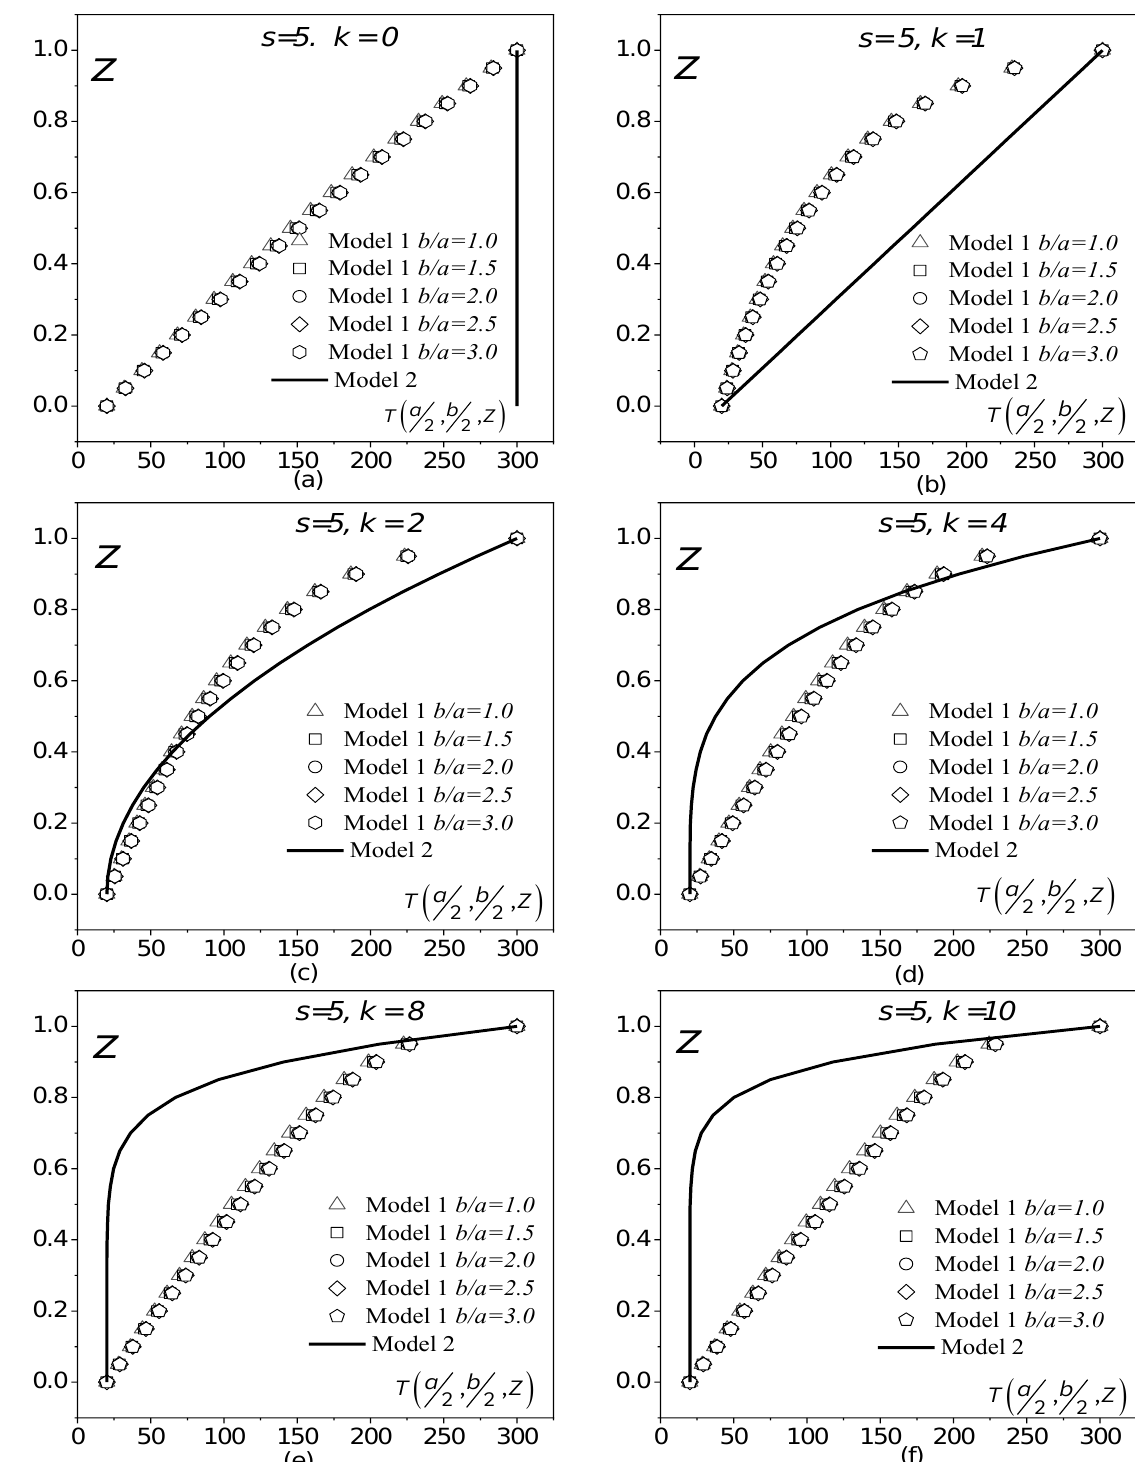
Fig. 5. Comparison between through thickness exact temperature variation and power law variation for different power index ( k) for square laminate ( b/a =1) and rectangular laminate ( b/a =1.5,2.0,2.5,3.0) material set